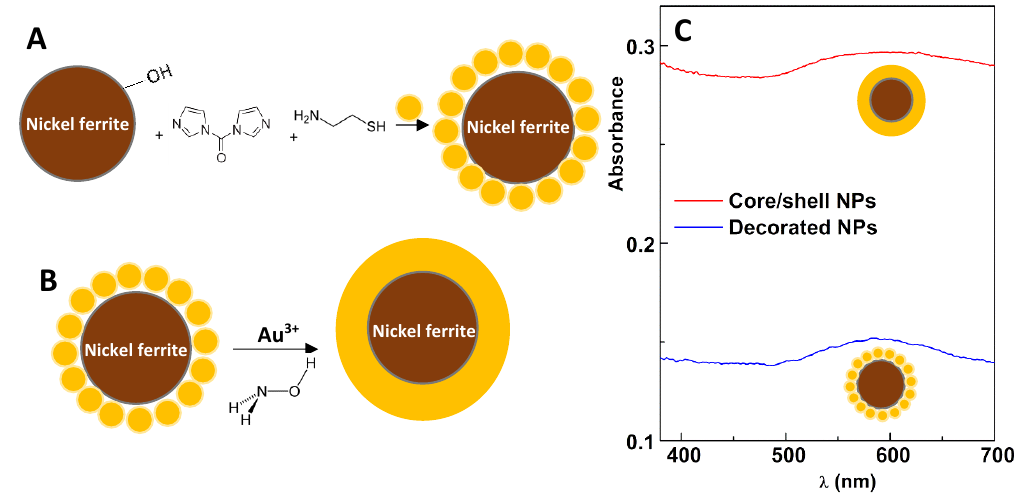
Figure 3. ( A ) Schematic representation of the synthesis of gold-decorated nickel ferrite nanoparticles dispersed in ethanol. ( B ) Schematic representation of the synthesis of core / shell nickel ferrite /